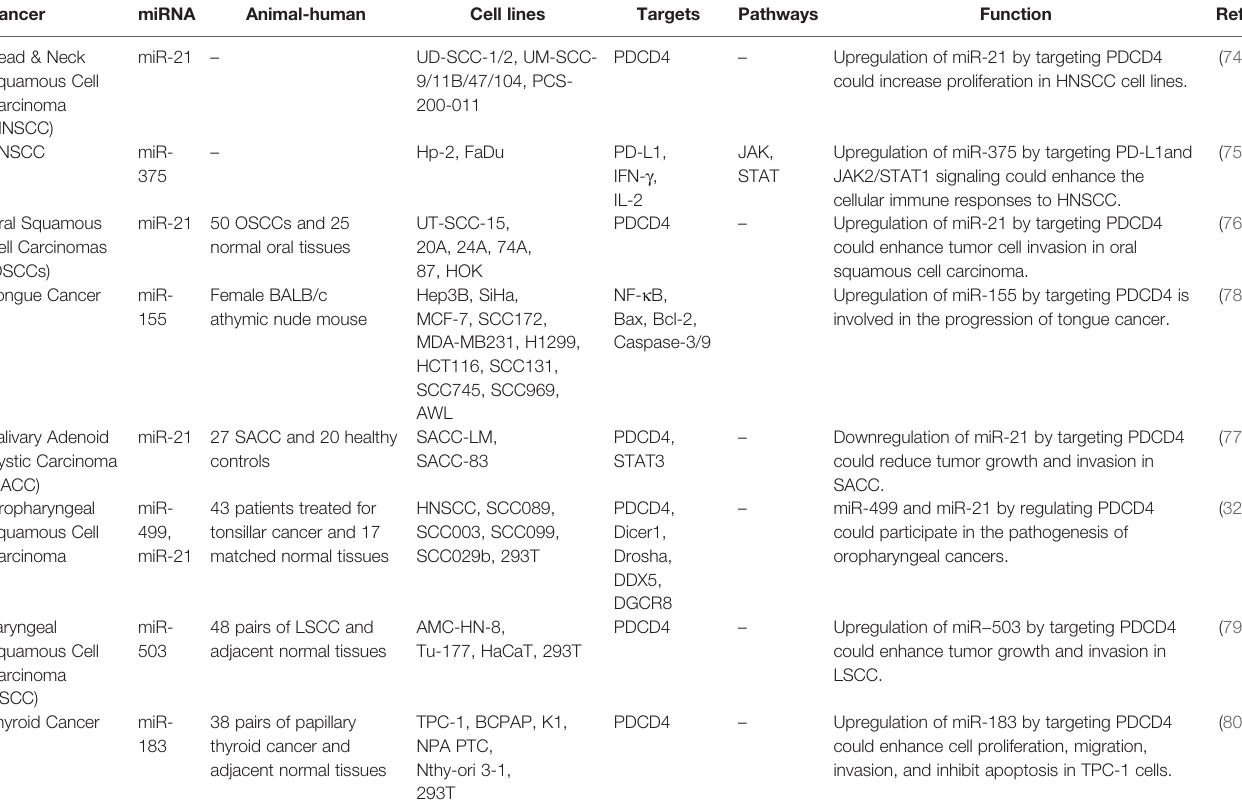
TABLE 6 | Interaction between miRNAs and PDCD in head and neck